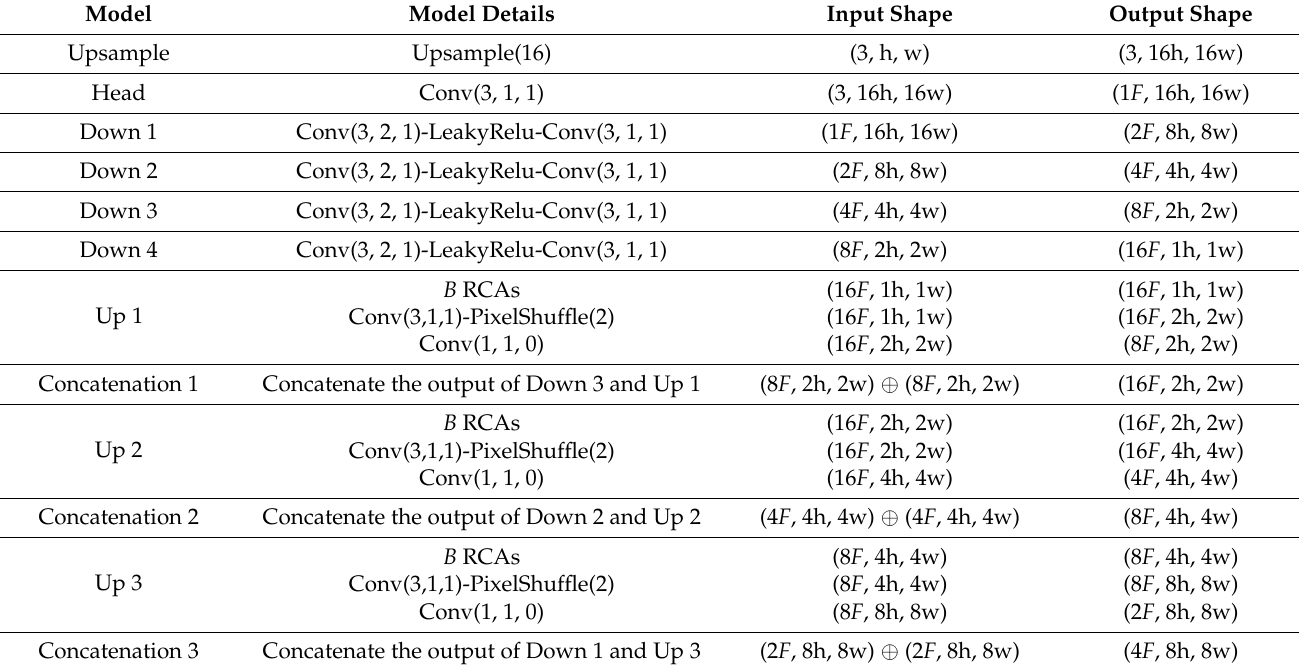
r = 16 in all RCABs, and the negative slope is 0.2 for all LeakyReLU. Table 1. The network architecture configuration of generator based on dual learning scheme. The con- volutional layer is represented as Conv (kernel_size, stride, padding), and h and w are the height and width of the input LR images. B is the number of RCABs, and F is the number of base feature